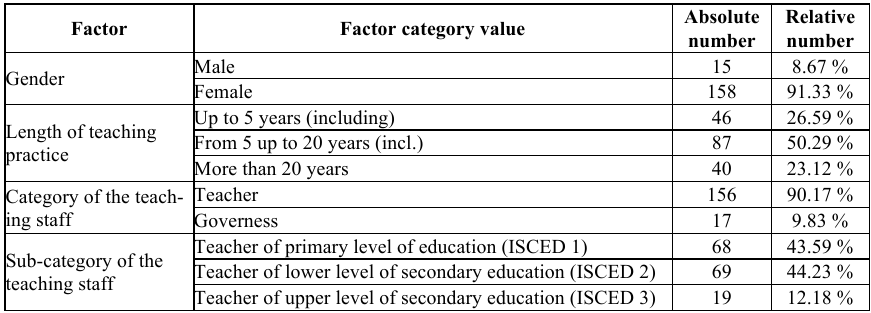
Table 1. Description of the research sample (source: own research)